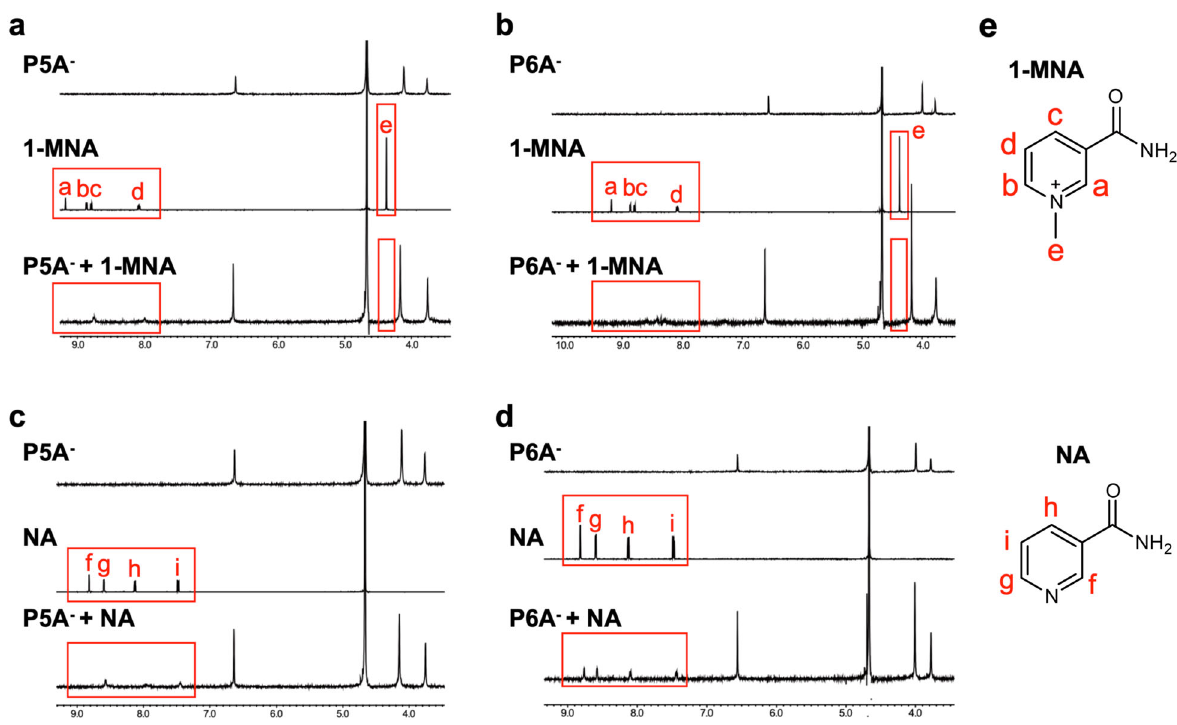
Fig. 2 P5A forms host-guest complexes with both 1-MNA and nicotinamide, but P6A selectively binds to 1-MNA. a – d Partial 1 H NMR spectra of the indicated complexes. The proton peaks of the guest molecule are indicated by the red rectangles: ( a ) P5A, 1-MNA, and P5A and 1-MNA, ( b ) P6A, 1-MNA, and P6A and 1-MNA, ( c ) P5A, nicotinamide (NA), and P5A and NA, and ( d ) P6A, NA, and P6A and NA. e Structures of the guest